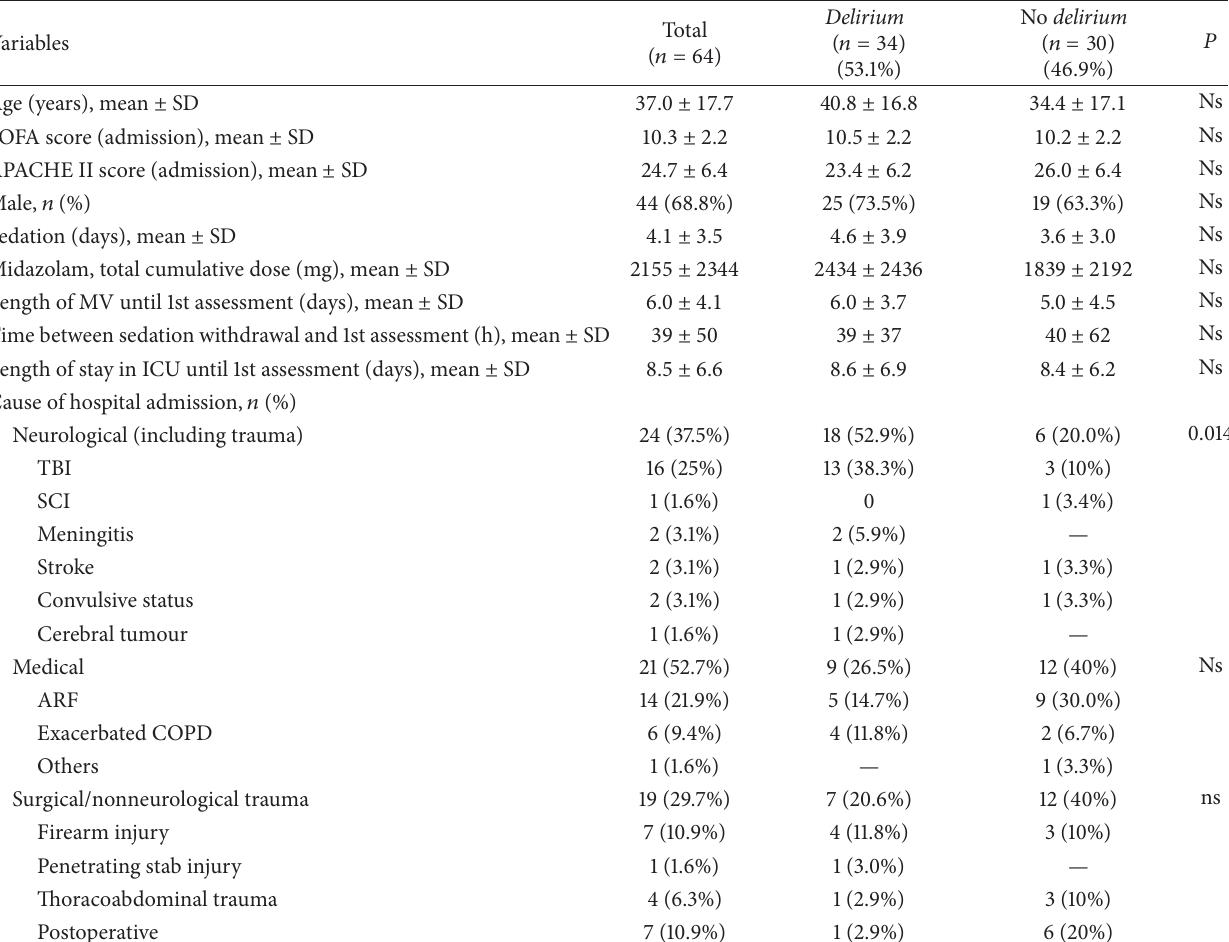
Table 1: Characteristics of the patients included in the study.